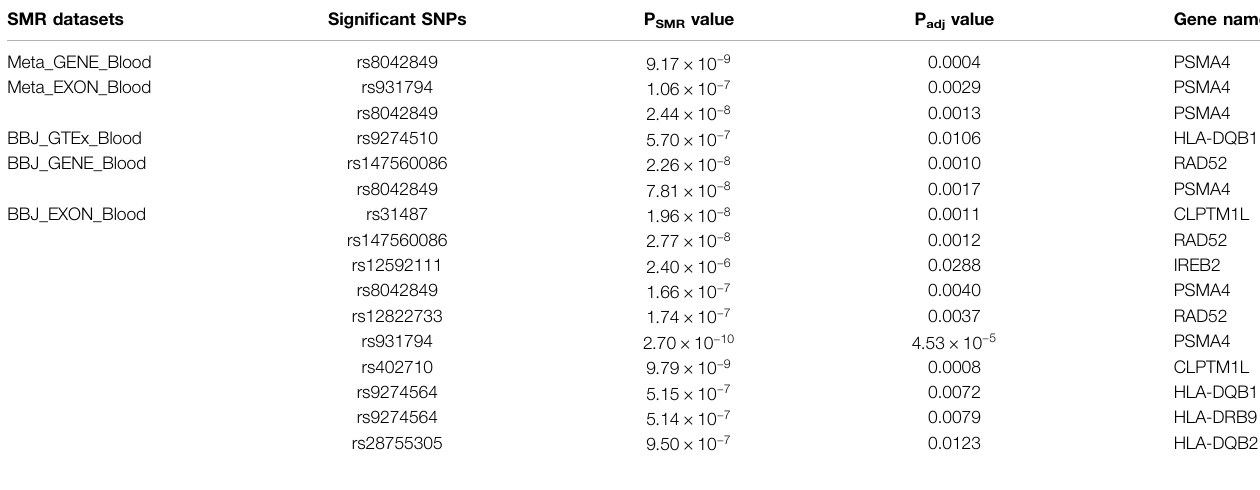
TABLE 2 | The list of discovered lung cancer causative genes by the SMR analysis. This list showed the signi fi cant SNPs and genes found in different datasets, and the corresponding value of P SMR and P adj